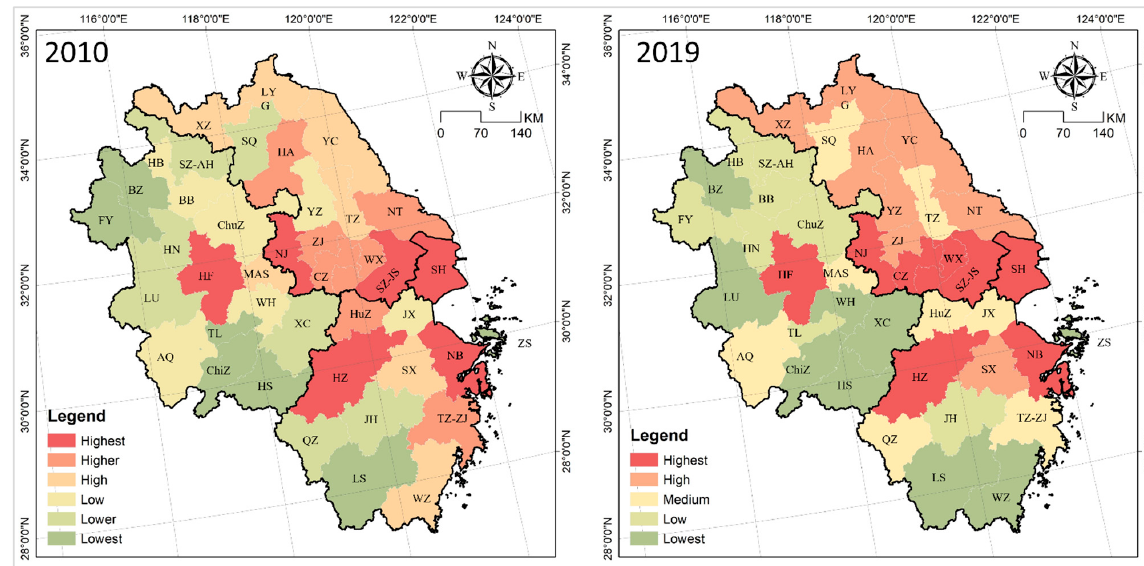
Land 2022 , 11 , x FOR PEER REVIEW 15 of 37